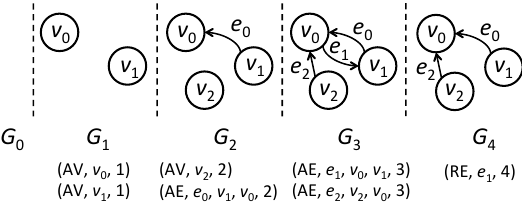
Fig. 1 The evolution of a sample social